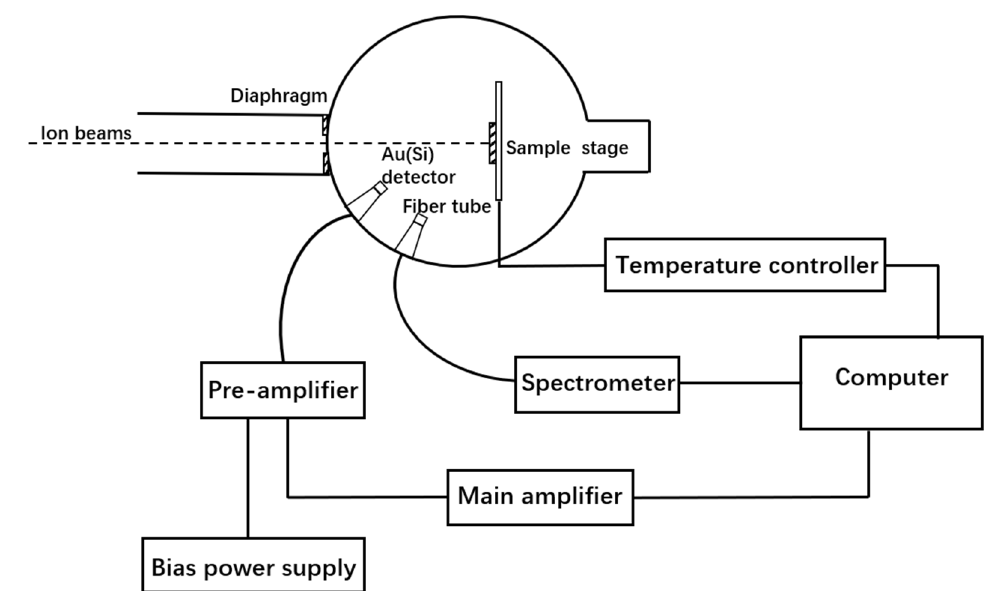
Figure 2. Schematic diagram of the IBIL experimental setup.